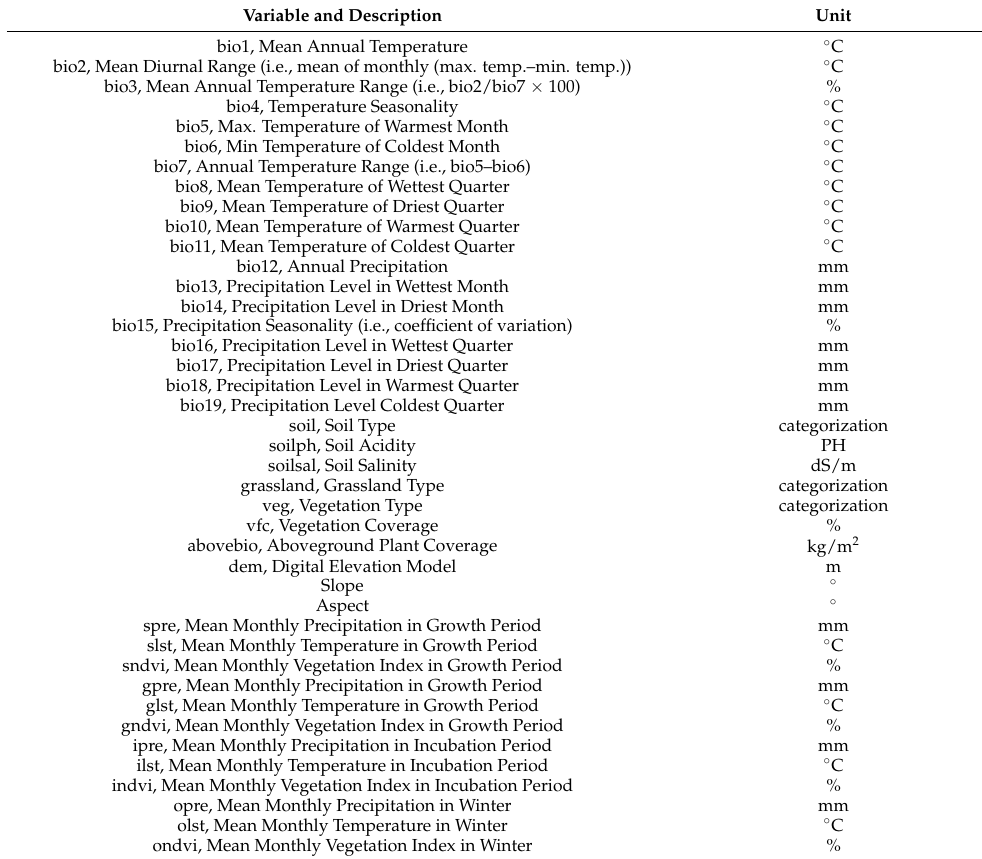
Table 1. The environmental climate variables in our Maxent